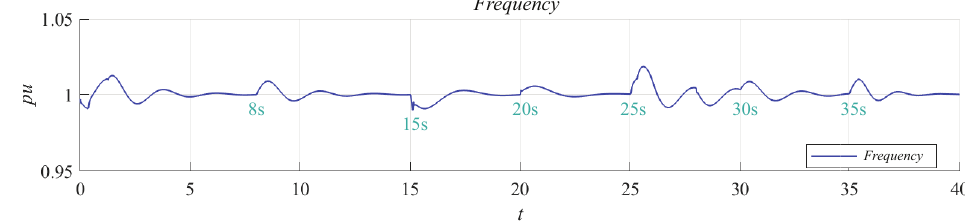
Figure 20. System frequency in per unit for case study 2.